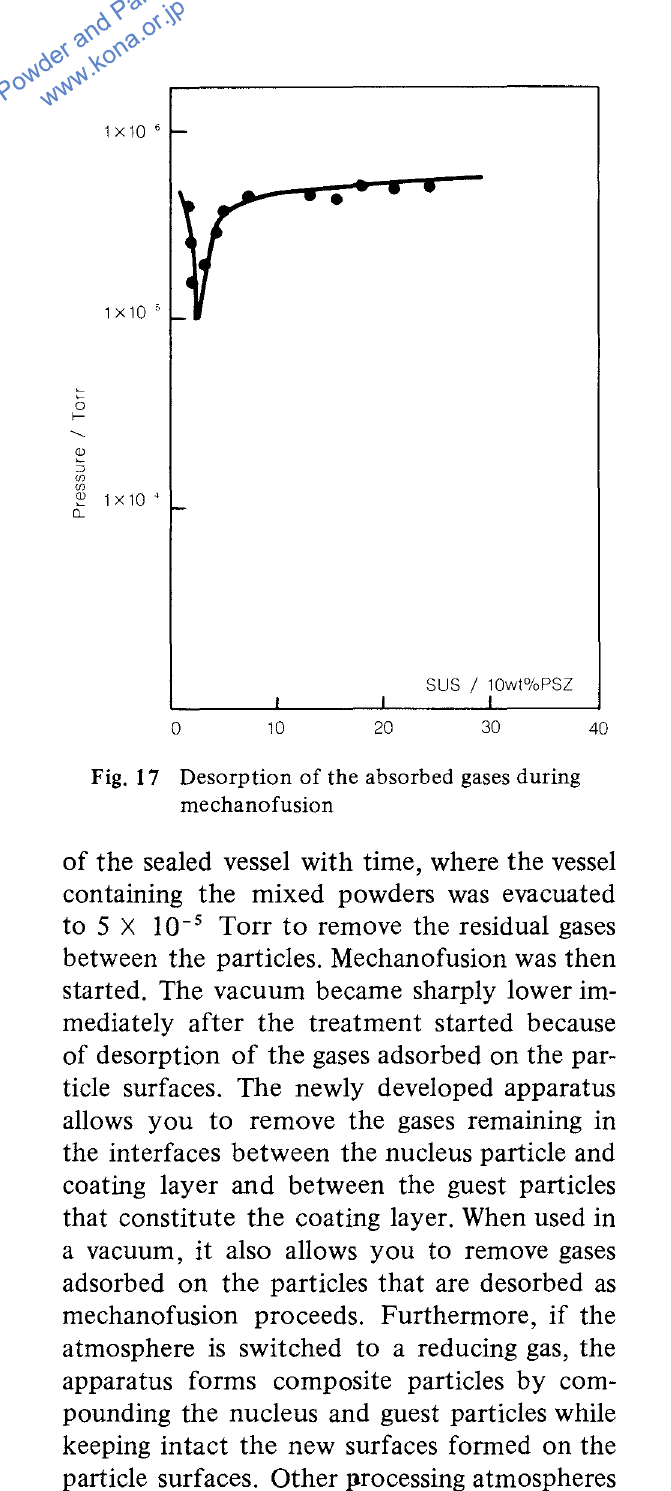
Fig. 18 Morphologies of composite particles not water cooled in an Ar atmosphere versus those that have been water-cooled under a vacuum